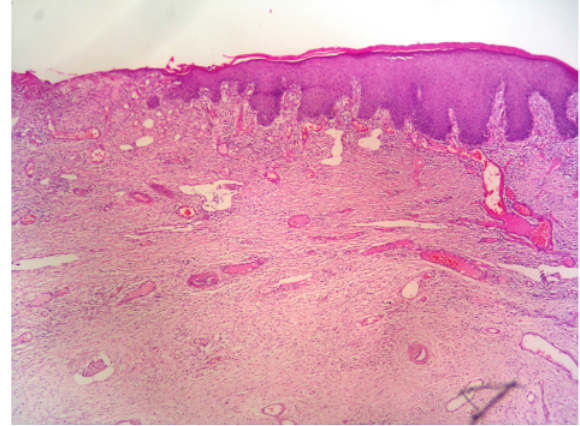
Figure 2: Fibrocollagenous stroma covered by stratified squamous epithelium with areas of